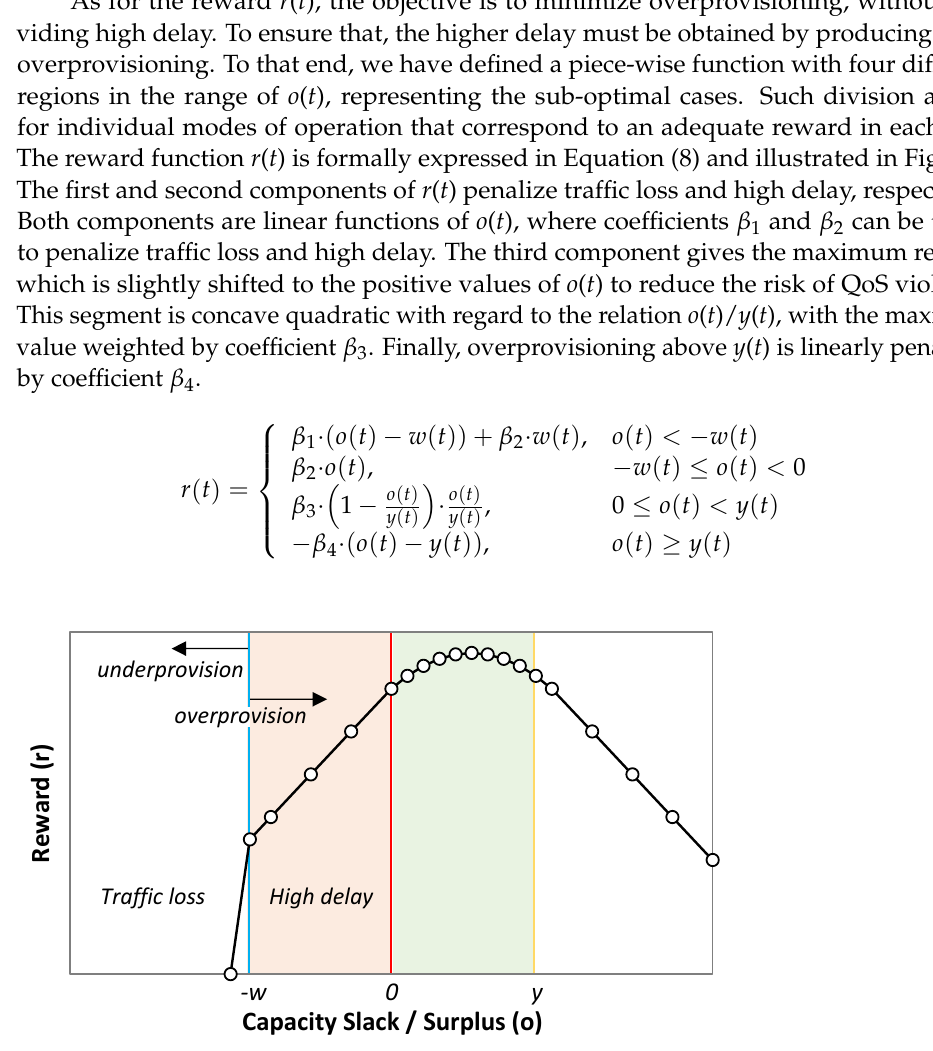
Figure 7. Reward function vs. capacity slack/surplus.